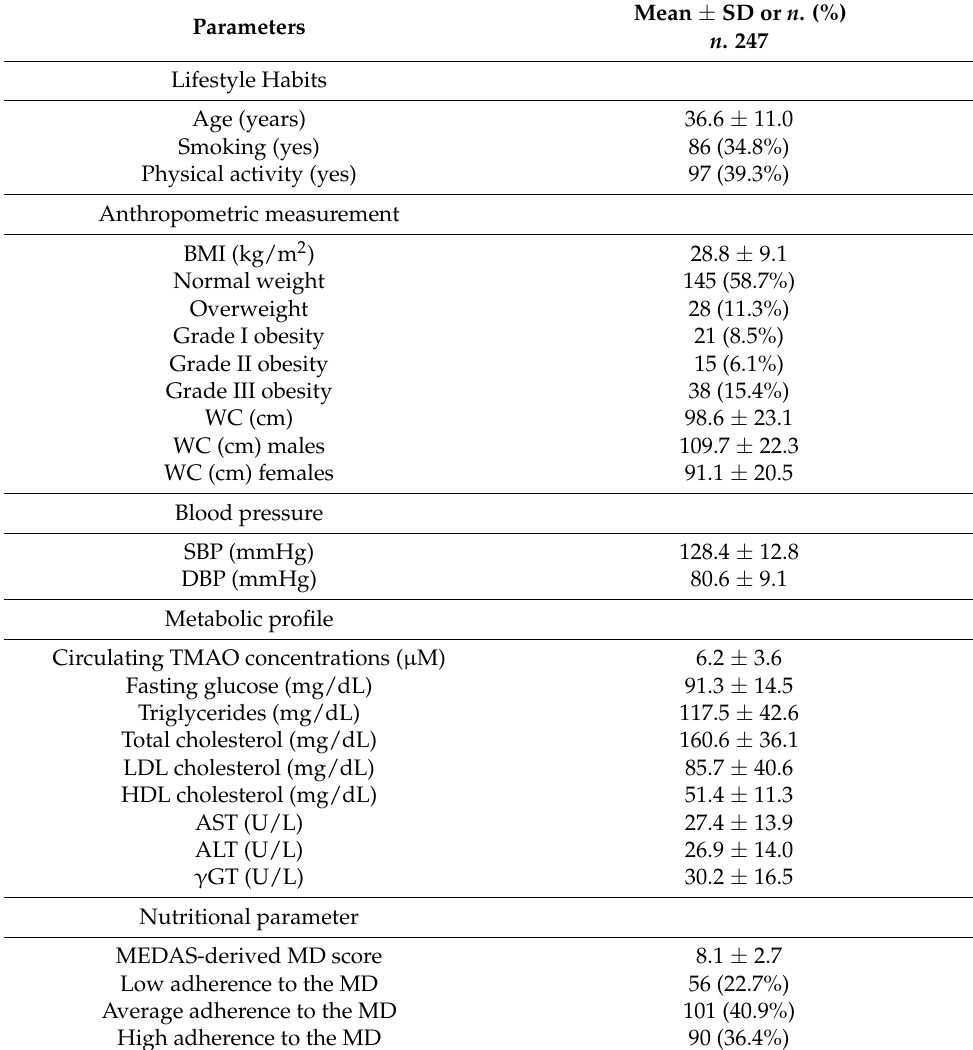
Table 1. Lifestyle information, BMI, WC, blood pressure, metabolic profile, MEDAS-derived MD score, and chronotype of study